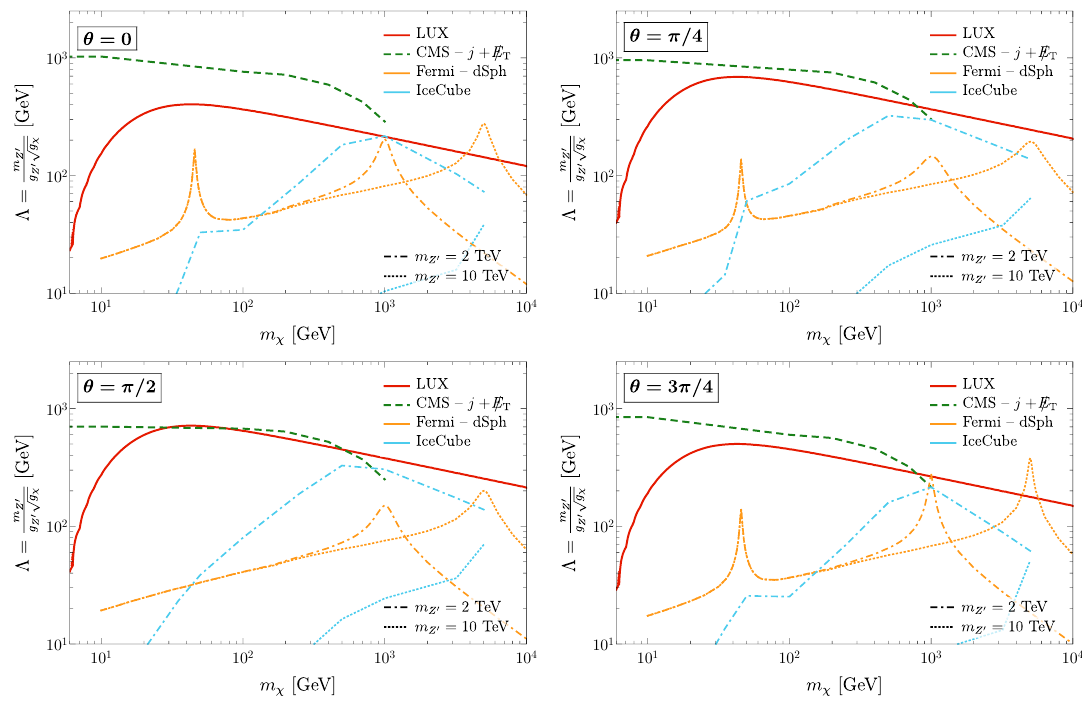
Figure 7 . ( Replaces (cid:12)gure 7, 8 of the original paper .) Exclusion limits for the four values of (cid:18) we consider. The bound on spin dependent cross section for (cid:18) = 0 (as on (cid:12)gure 7 of the original paper) is not shown, since there is no such scattering. For the Fermi and IceCube bounds, we show two lines corresponding to m Z 0 = 2 or 10